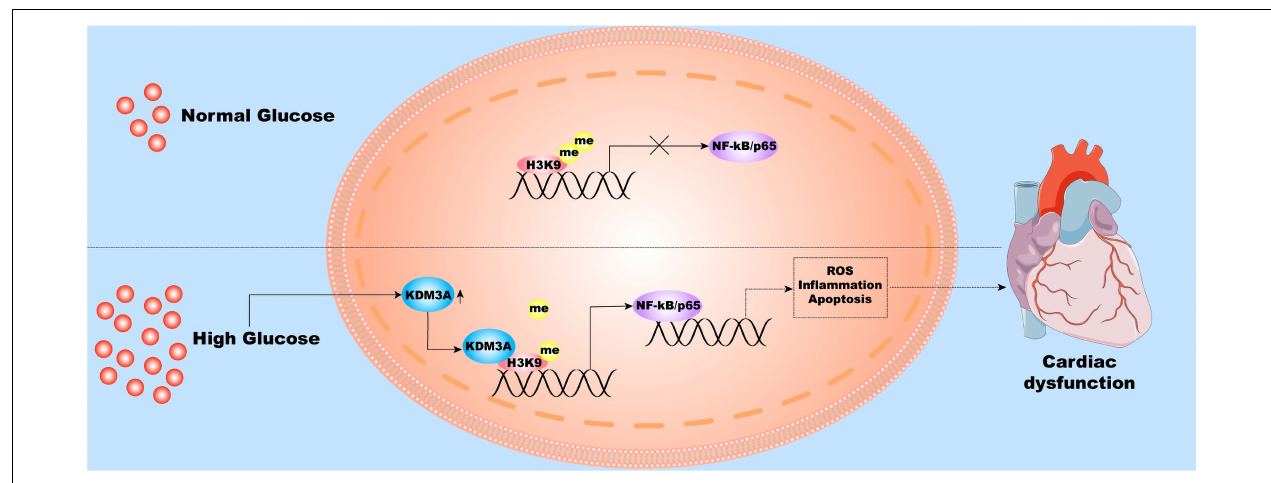
FIGURE 8 | The molecular and cellular mechanisms underlying hyperglycemia-induced persistent myocardial injury and cardiac dysfunction. Hyperglycemia stimulation induces the over-expression of KDM3A; therefore, the KDM3A binds to the promoter region of the NF- κ B/P65 gene and reduces the level of H3K9me2, thereby continuously promoting NF- κ B/P65 transcription. As a result, NF- κ B/P65 further results in long-lasting ROS accumulation, inflammatory reaction, apoptosis, and cardiac